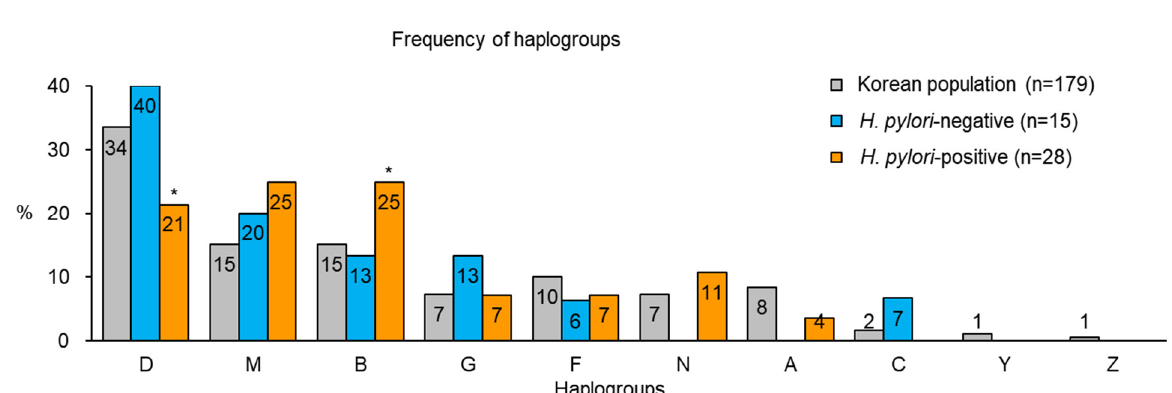
Figure 2. Frequencies of mtDNA haplogroups in Korean population and H. pylori -negative and -positive populations. H. pylori -positive population showed a significantly higher frequency of haplogroup B and a significantly lower frequency of haplogroup D than that of the H. pylori -negative population and the Korean population (* p <